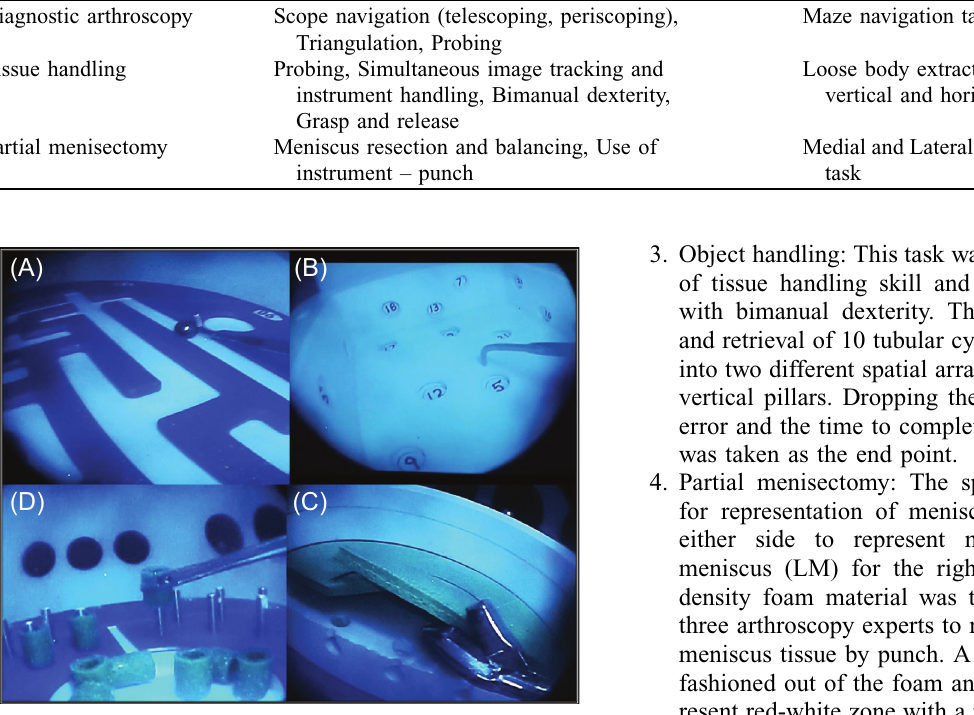
Figure 2. Opaque dome (OD) modules for ‘‘FAST’’ bench workstation. (A) Maze navigation, (B) number probing, (C) object handling-vertical pillars and (D) meniscus